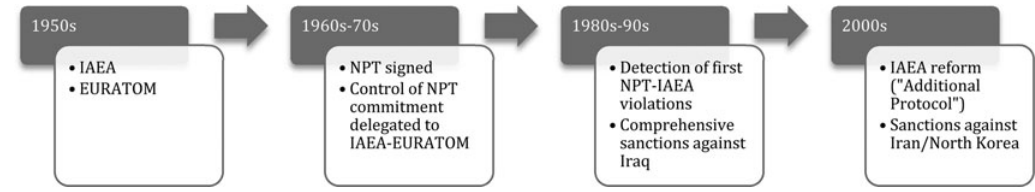
Figure 1: The Gradual Constitution of the Nonproliferation Regime